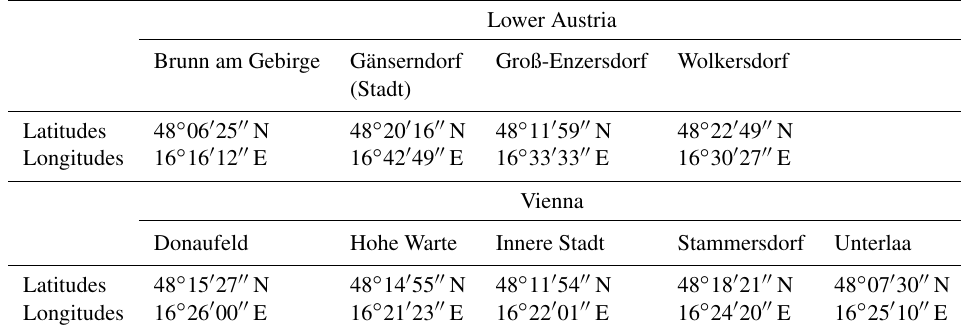
Table 5. Overview of selected meteorological stations, operated by the Austrian official weather